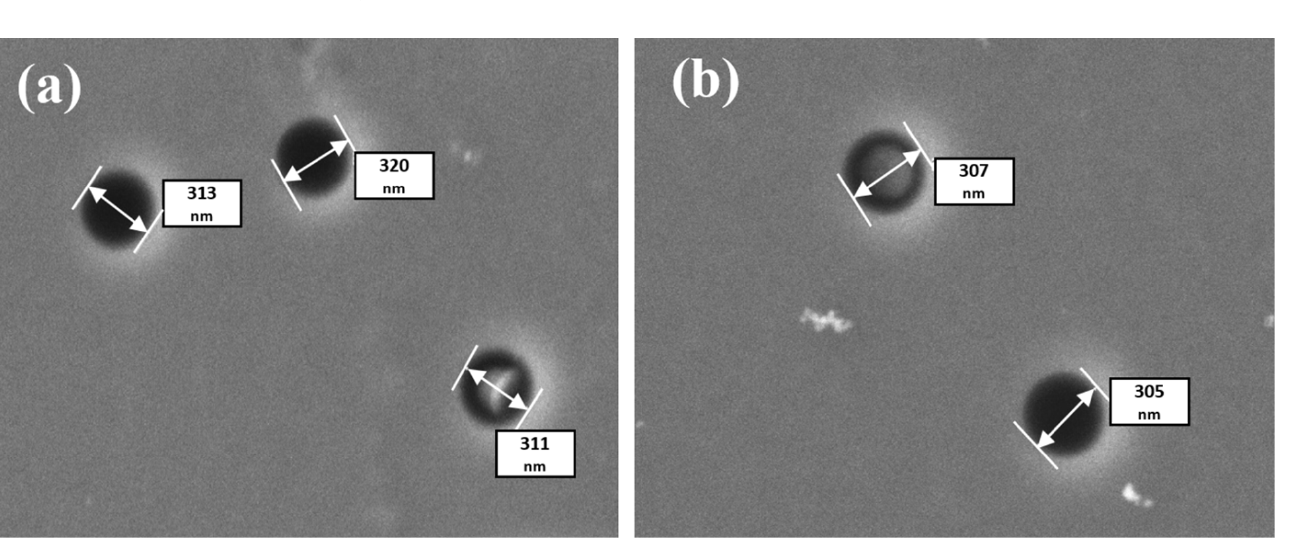
Figure 3. SEM images of the pores after ED with different voltages: ( a ) U = 1.5 V and ( b ) U = 1.75 V. Pore diameter ~ 300 nm.